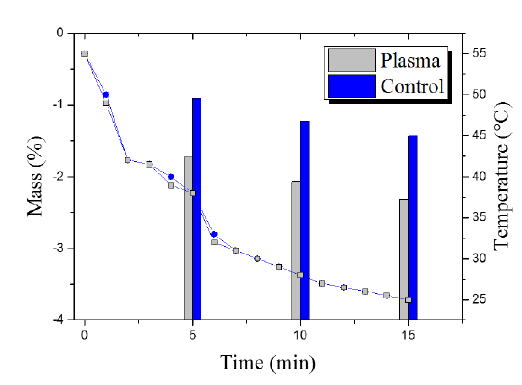
Figure 8. Mass loss (bars) and temperature variation (lines) during experiment 2.